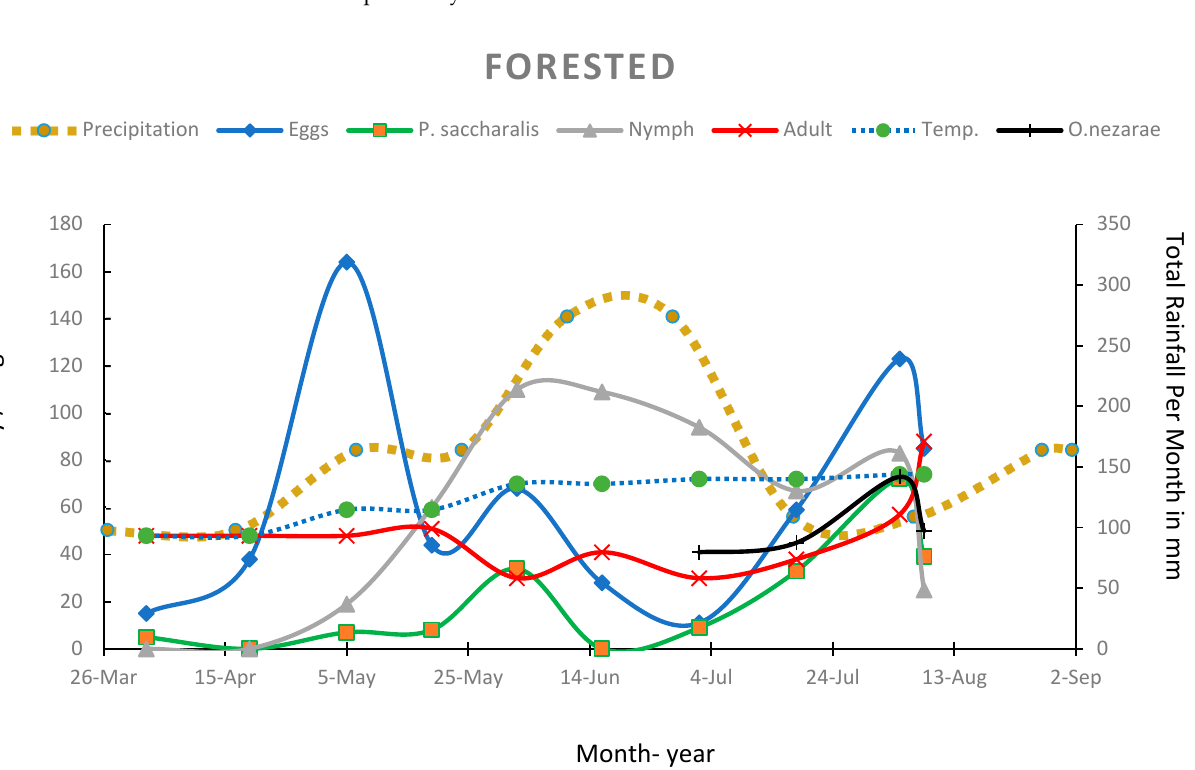
Figure 5. Population dynamics of M. cribraria and P. saccharalis for most active forested site in 2017. Host plants: Pueraria montana (kudzu).